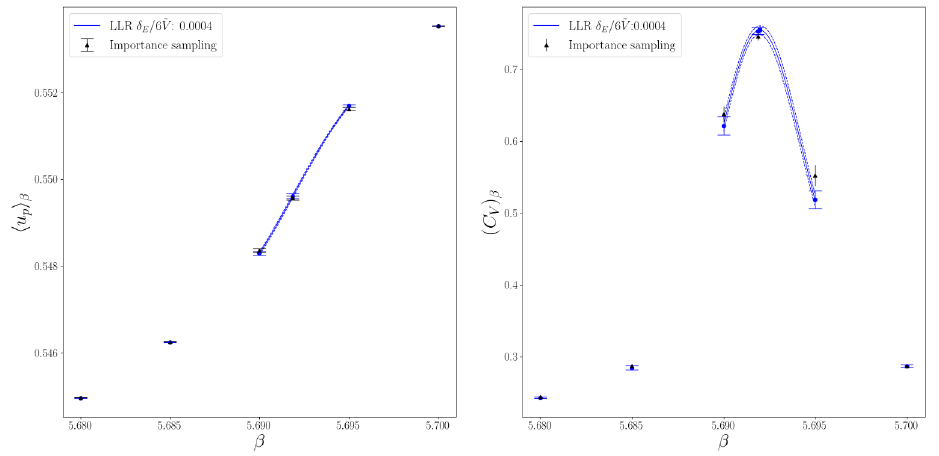
Figure 2: Thermodynamic observables measured with the LLR method (blue circles), com- pared to results from standard importance sampling (black triangles), for SU(3) Yang-Mills gauge theory on a 4 × 20 3 lattice. The LLR calculation uses energy intervals of size δ E / 6 ˜ V = 0 . 000374281 in the energy range from E 0 / 6 ˜ V = 0 . 439487341 to E 54 / 6 ˜ V = 0 . 459698522. The blue curves are reconstructed observables from LLR method with a finer resolution in β , restricted to the region around the phase transition. Left panel: average plaquette ⟨ u p ⟩ against ⟩ − ⟨ u ⟩ 2 against the coupling β the coupling β . Right panel: specific heat C V ≡ ⟨ u 2 p p